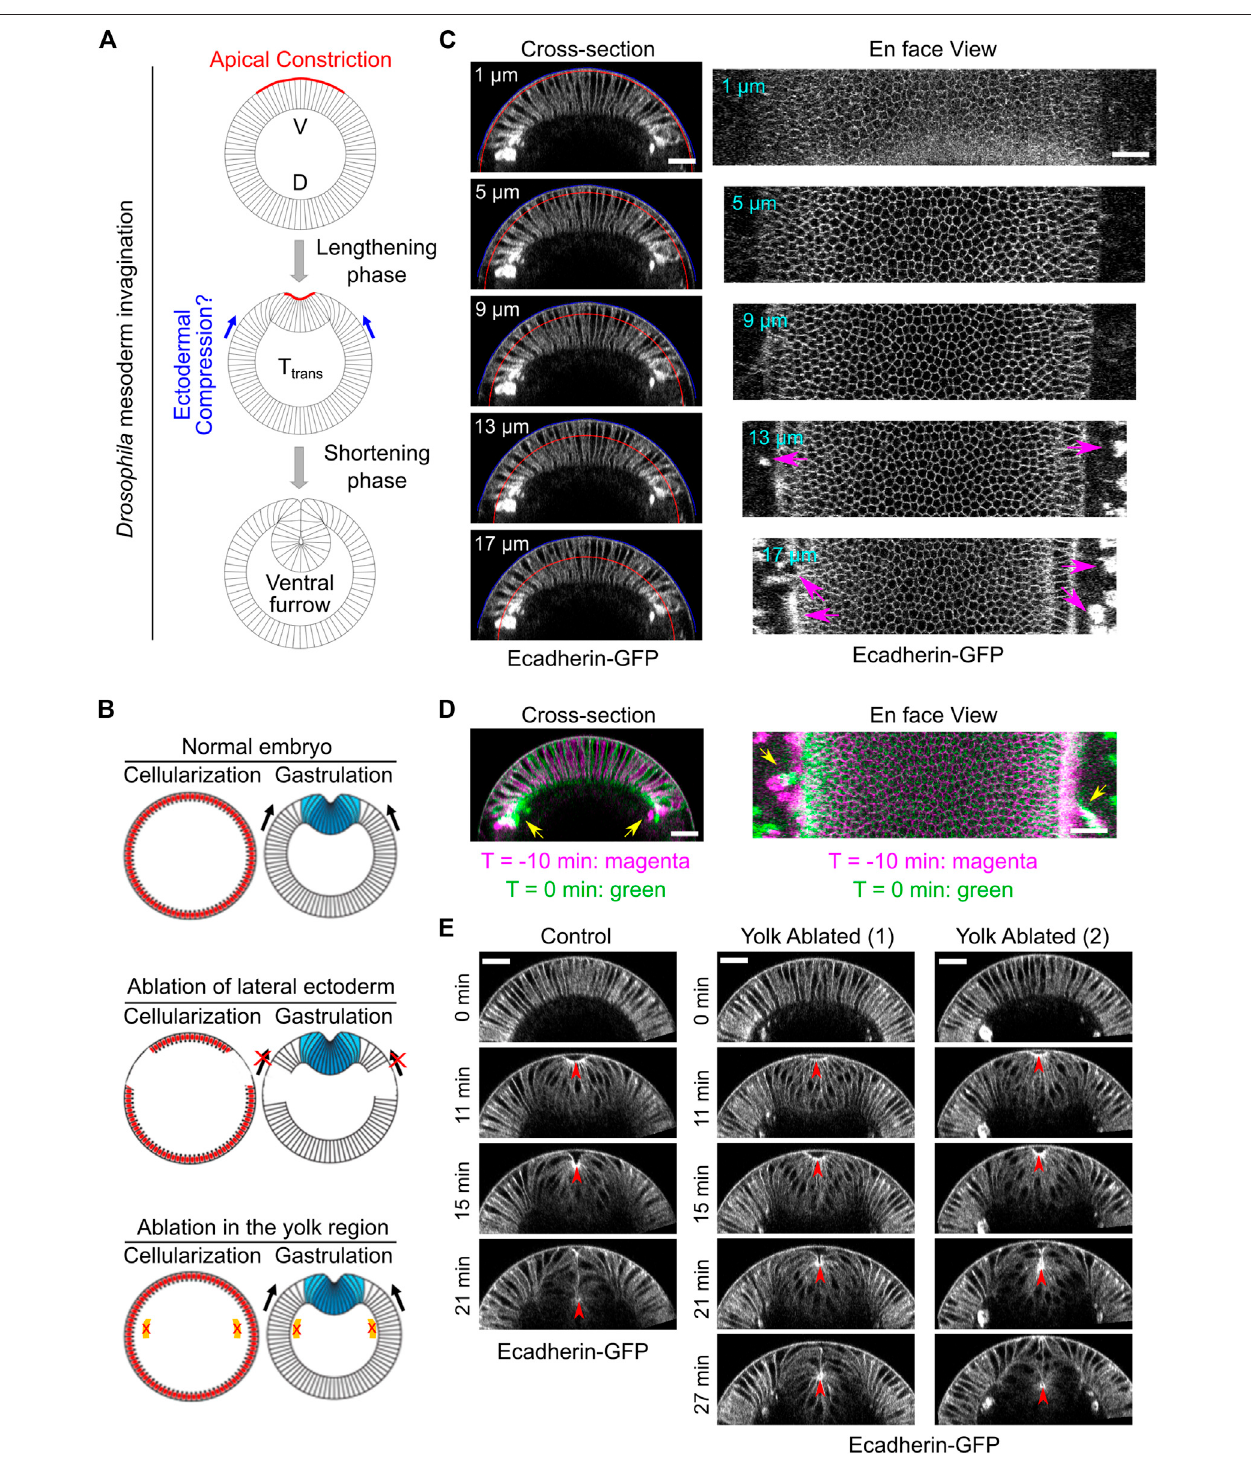
FIGURE 1 | Laser disruption of cell formation in the lateral ectodermal region prior to gastrulation. (A) Schematics illustrating mesoderm invagination during Drosophila gastrulation (given the important role of apical constriction in the process of ventral furrow formation, in all images shown in this paper, the apical side of the mesodermepitheliumisfacingup).Whiletheroleofapicalconstrictioninmesoderminvaginationhasbeenwelldocumented,itremainsunclearwhetherthesurrounding ectodermal tissue also contributes to mesoderm invagination. It has been postulated that the ectoderm may facilitate mesoderm invagination by exerting compressive stresses on the mesoderm epithelium. V: ventral; D: dorsal. (B) Schematics illustrating the strategy to test the requirement for the surrounding ectoderm in